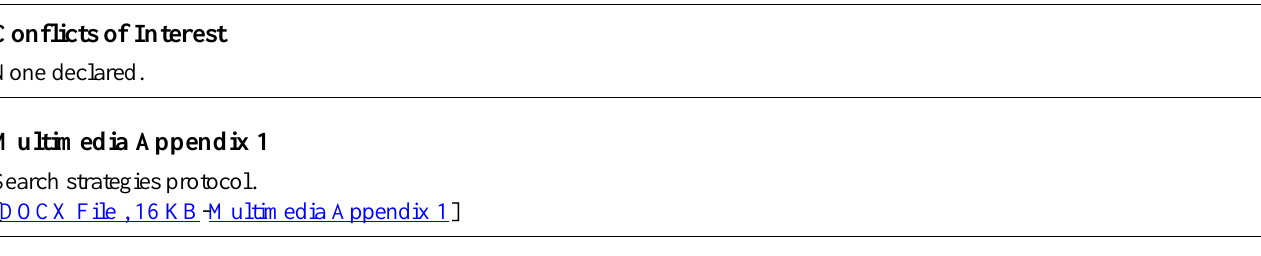
Table of intervention components of n=21 stress management apps with published research.